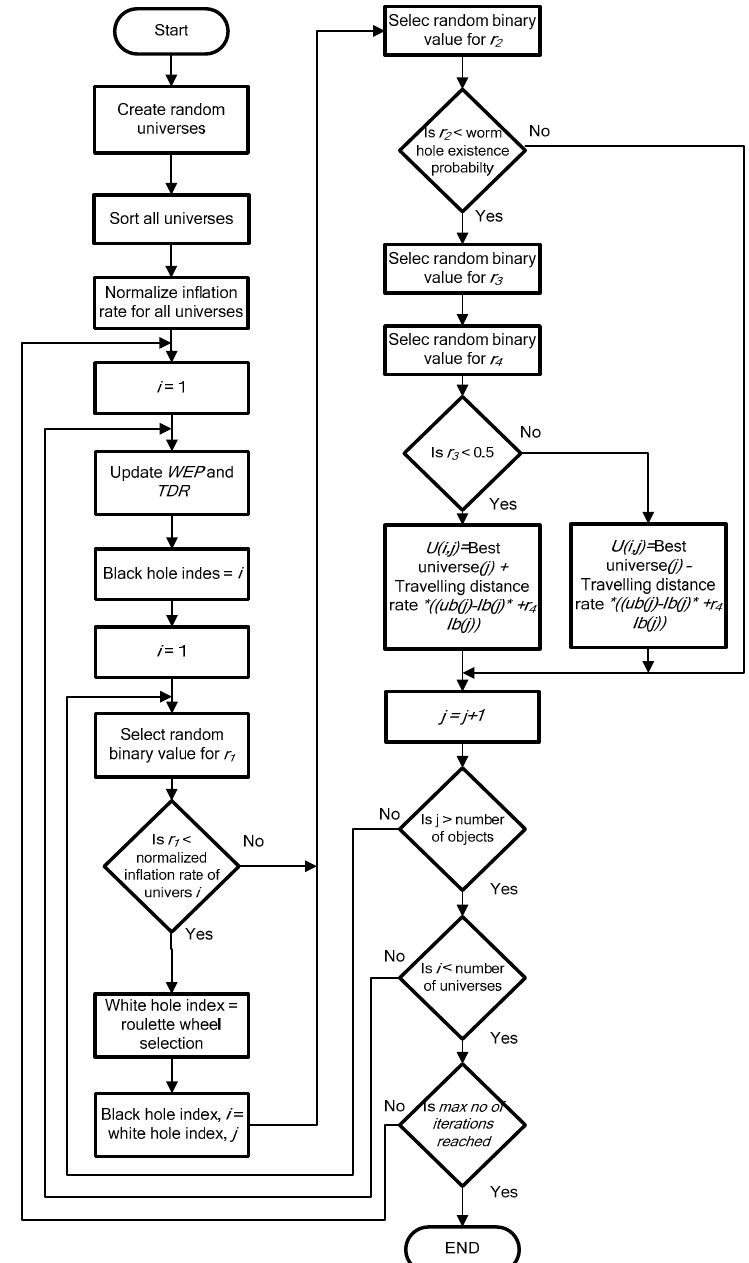
Figure 4. The flowchart of MVO algorithm.